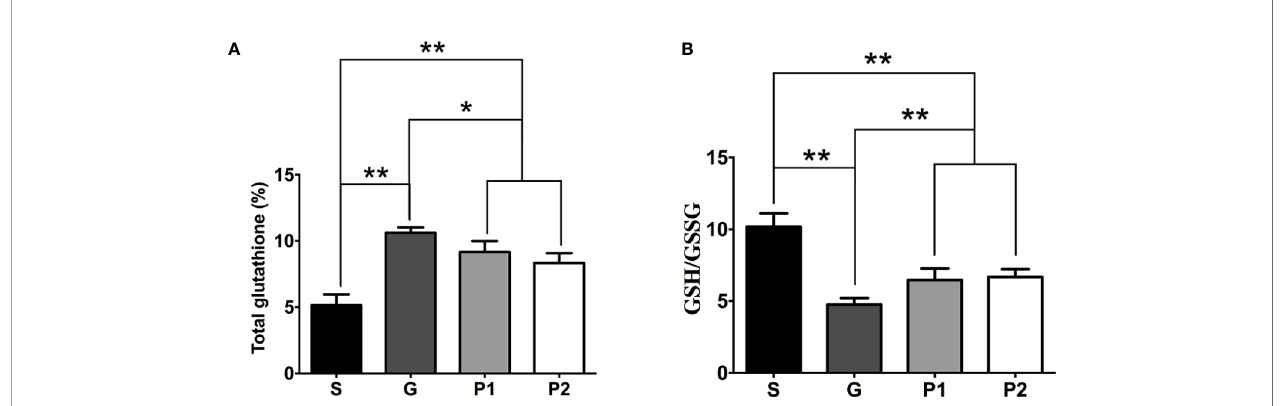
FIGURE 3 | On day 18 after C6 glioma model establishment, CSF was withdrawn from rats, and the total GSH content and GSH/GSSG ratio was determined. (A) Quanti fi cation of total GSH content in CSF (n=6/group). (B) The analysis of GSH/GSSG ratio (n=6/group). Data are presented as means ± SD. *P < 0.05 and **P < 0.01. Groups: S, sham; G, glioma; P1 and P2, propofol 20, and 40 mg/kg -1 /h -1 , respectively. CSF, cerebrospinal fl uid; GSH, glutathione; GSSG, glutathione disul fi de.